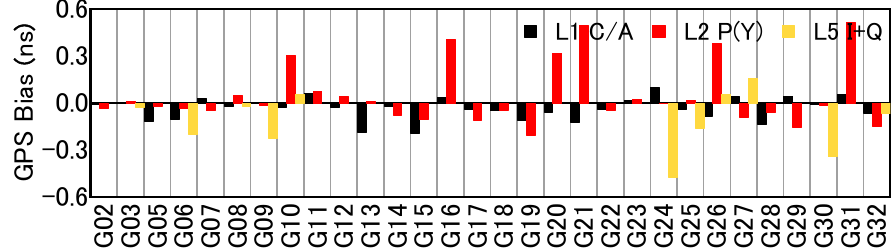
Figure 2. Receiver-related pseudorange biases of baseline ZIM2_ZIMM for GPS from DOY 101 to 160, 2019.